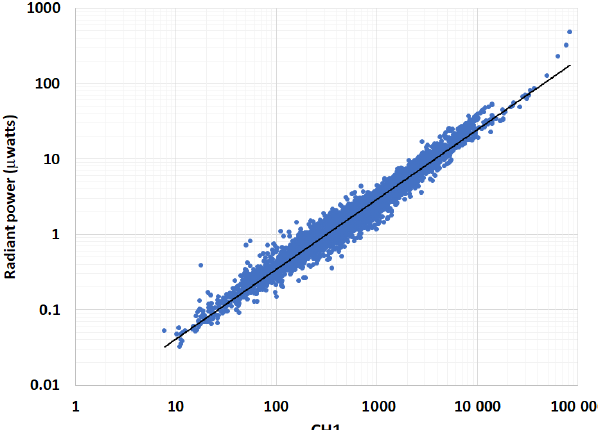
Figure 9. The 1h average CH1 reported values plotted against model-predicted radiant power (or energy) in µW on the photodi- ode. Both the CH1 and DMPS data were adjusted to STP condi- tions. The ordinary least squares regression line is also shown. The plot is based on 6839 1h averages at